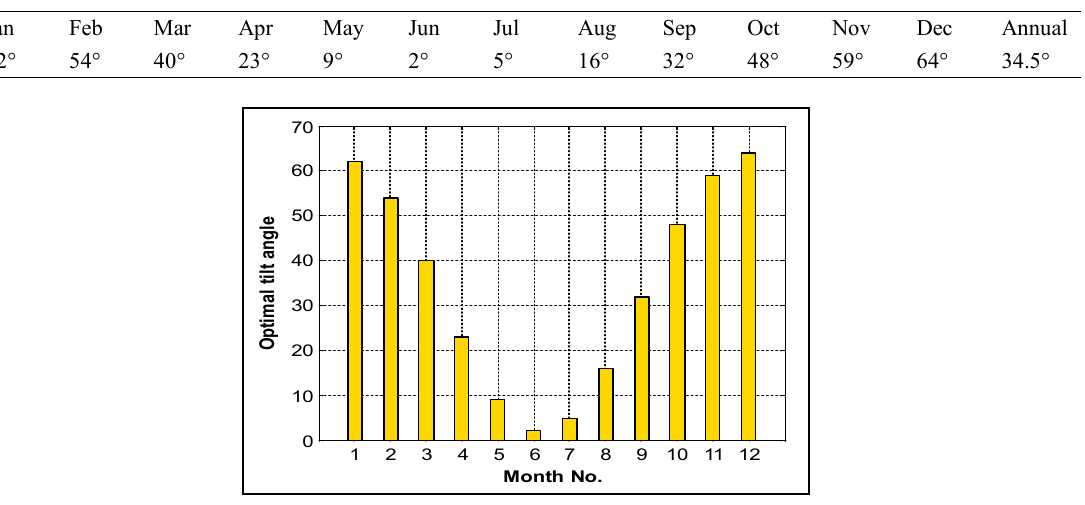
Table 7. Monthly optimal tilt angle using MATLAB for California.